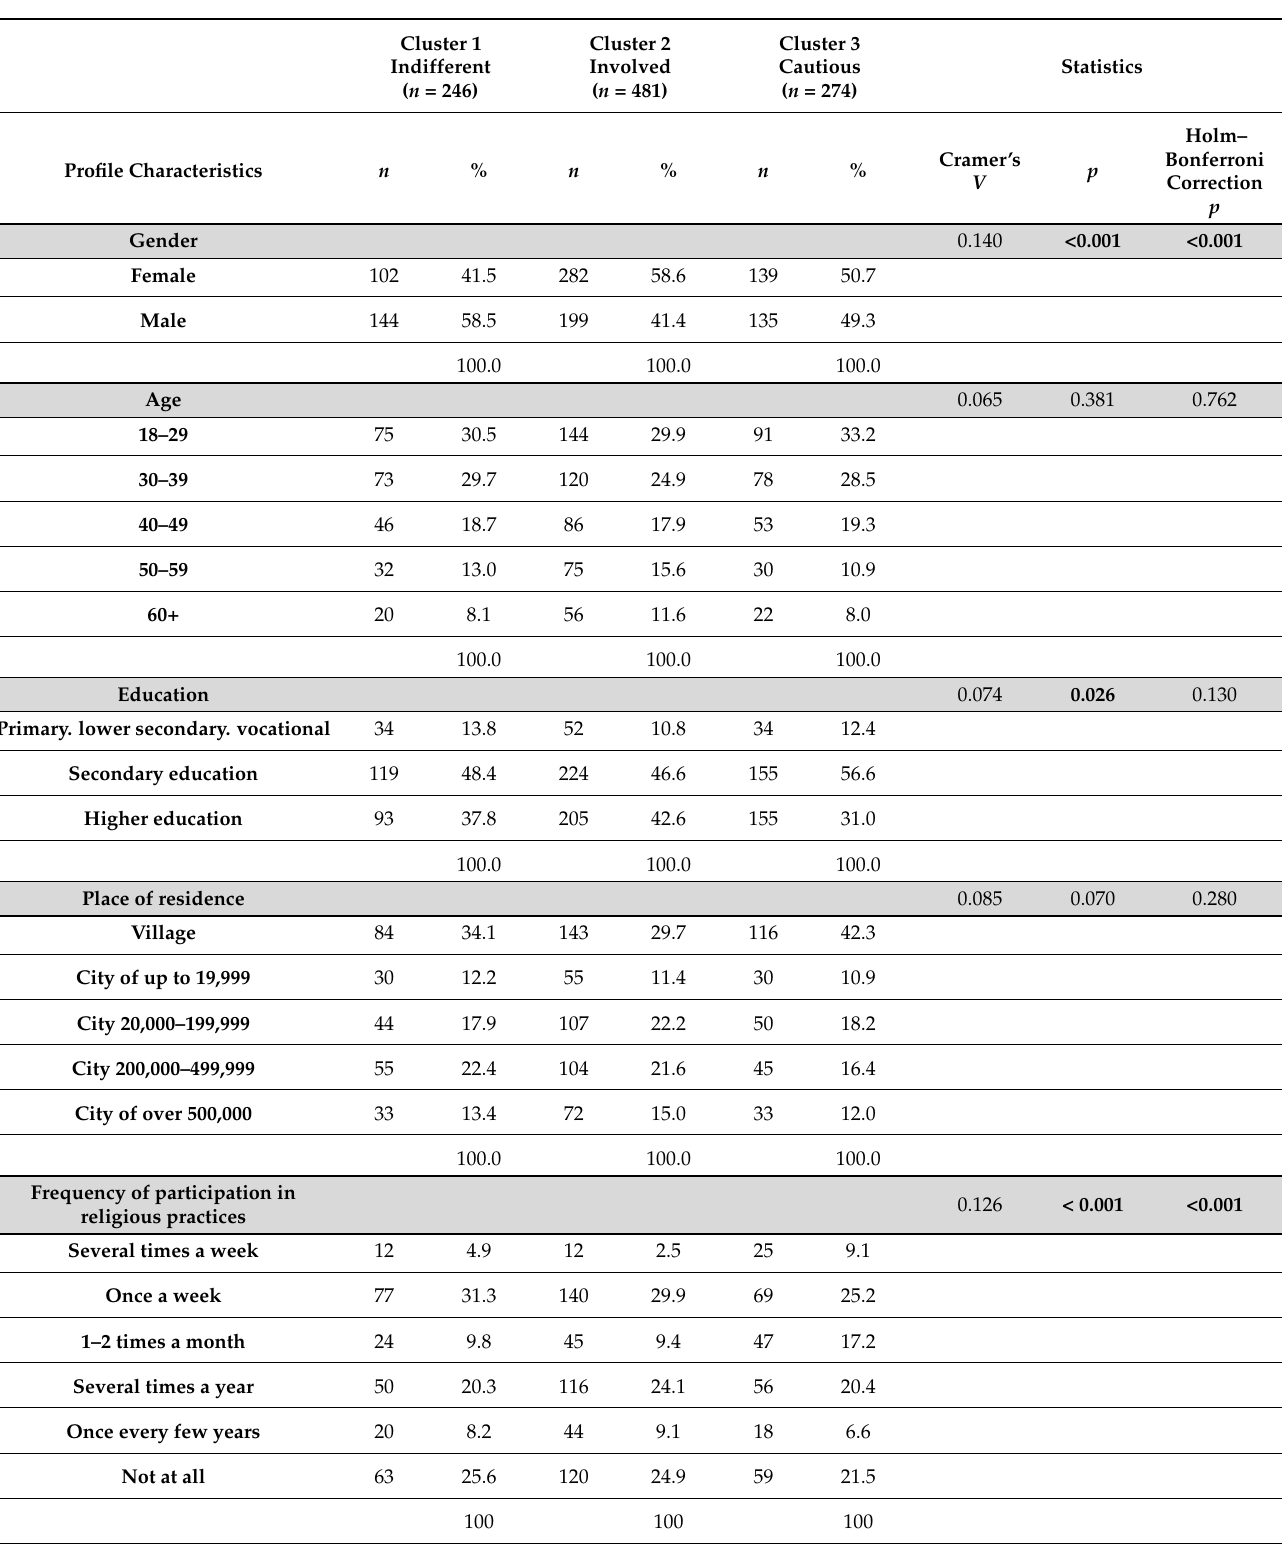
Table A4. A different method of calculating